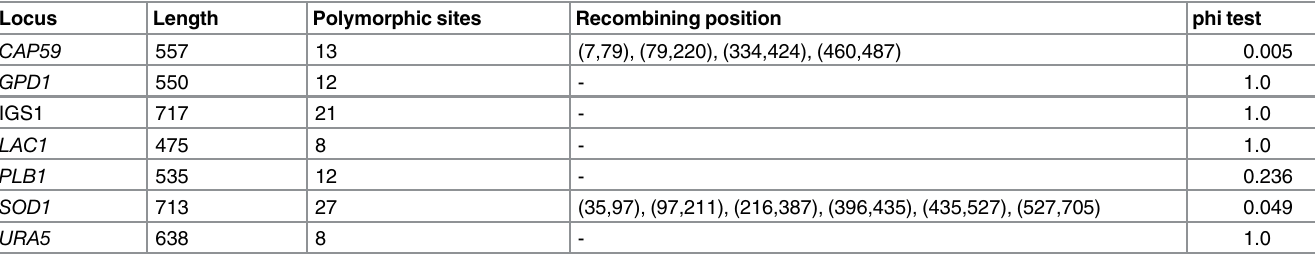
Table 2. Characteristics of the MLST Loci studied in 145 Brazilian C . gattii VGII isolates. Locus Length Polymorphic sites